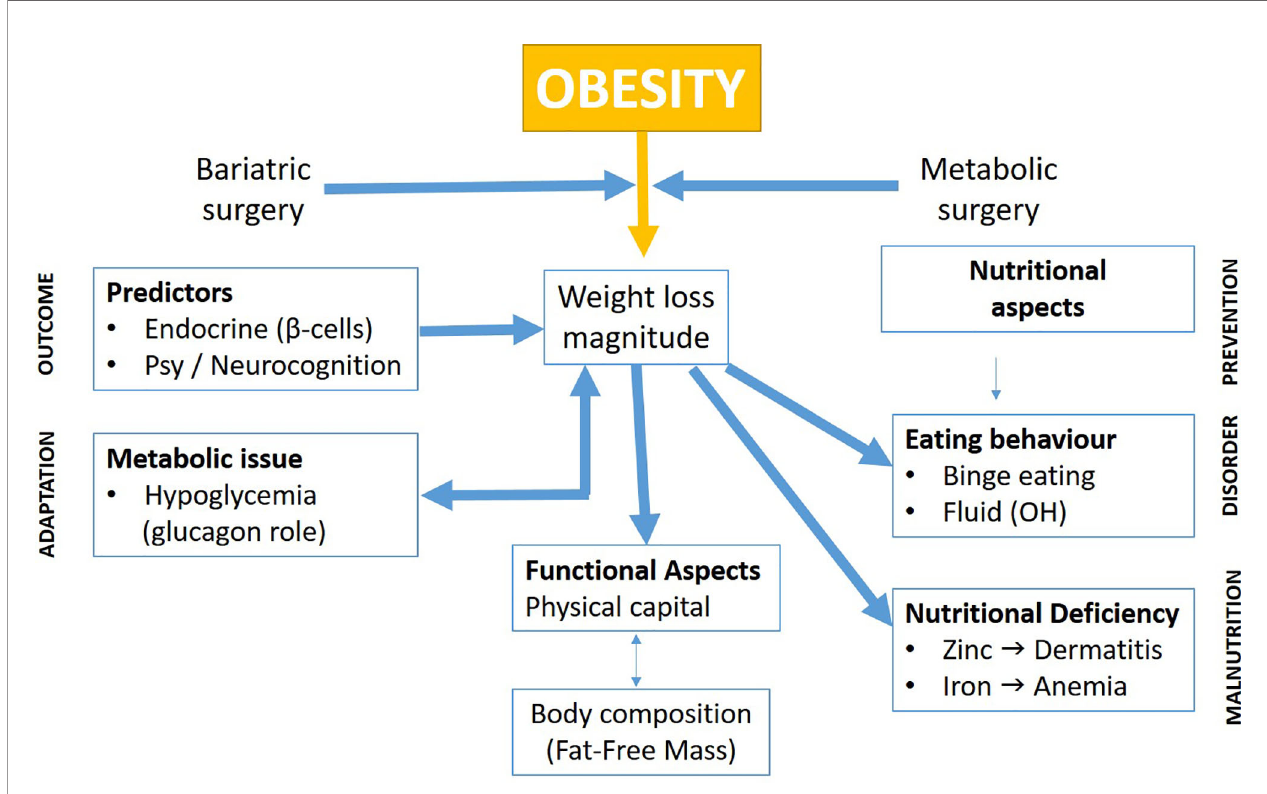
FIGURE 1 | Multidimensional effects of bariatric